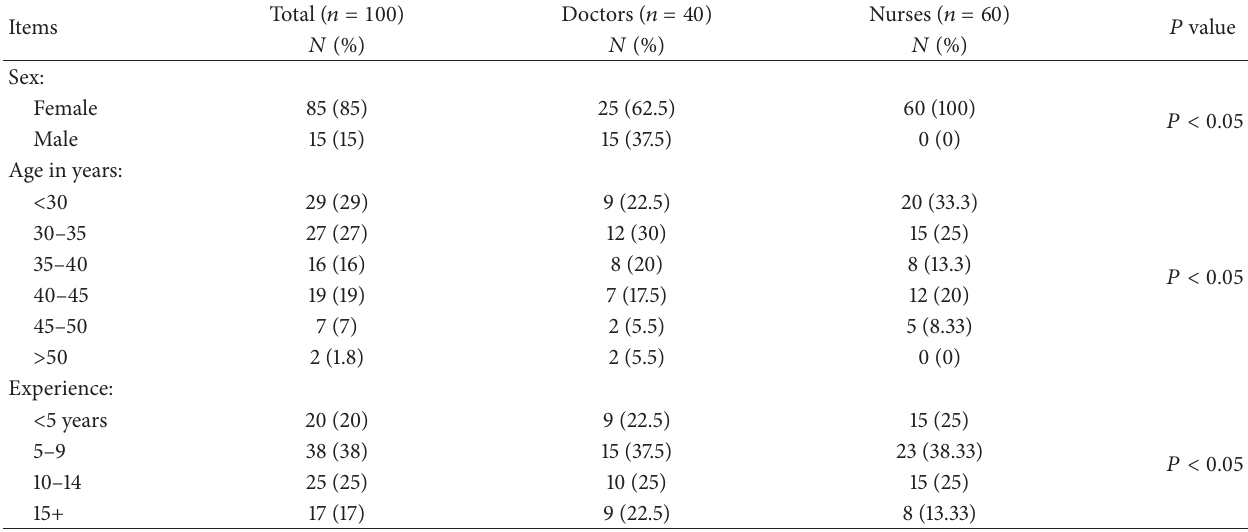
Table 1: Demographic characteristics of health workers.